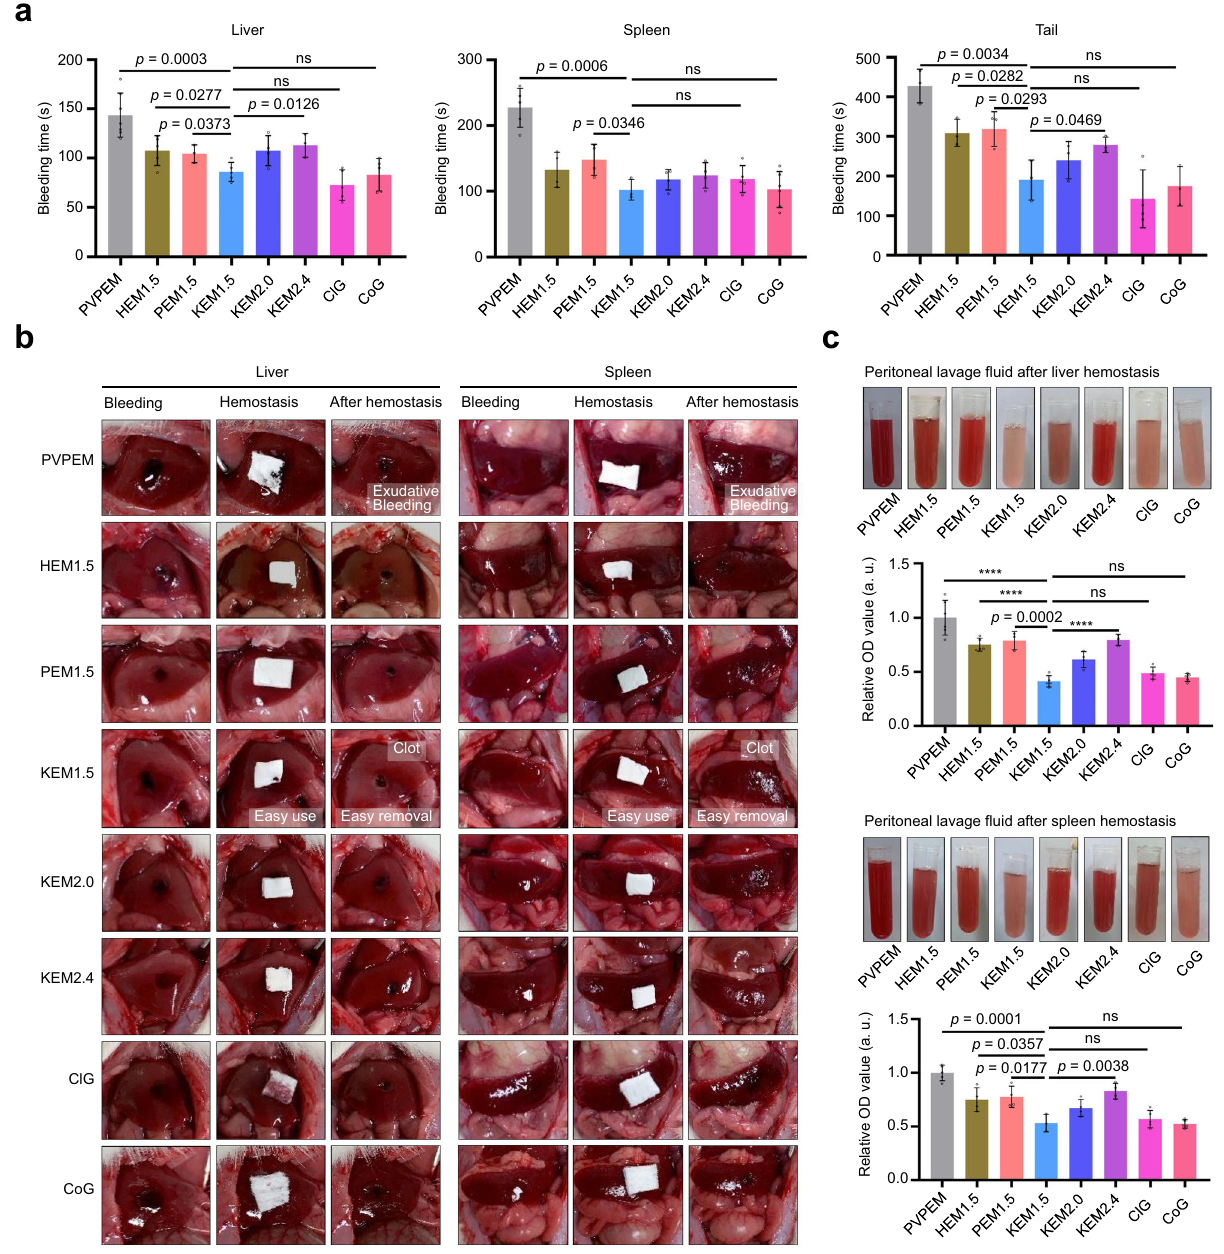
Fig. 4 In vivo clotting research. a Bleeding time of wounds treated with NEMs. In rat liver hemostasis model: PVPEM ( n = 7), HEM 1.5 ( n = 5), PEM 1.5 ( n = 3), KEM 1.5 ( n = 5), KEM 2.0 ( n = 4), KEM 2.4 ( n = 3), ClG ( n = 5) and CoG ( n = 5); in rat spleen hemostasis model: PVPEM ( n = 5), HEM 1.5 ( n =